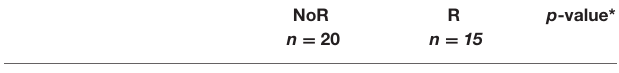
TABLE 2 | Baseline characteristics of responders and non-responders to Switzerland hemagglutinin antigen.